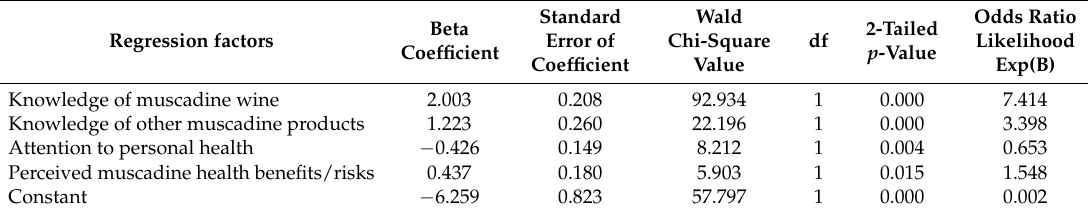
Table 5. Regression coefficients for buying muscadine